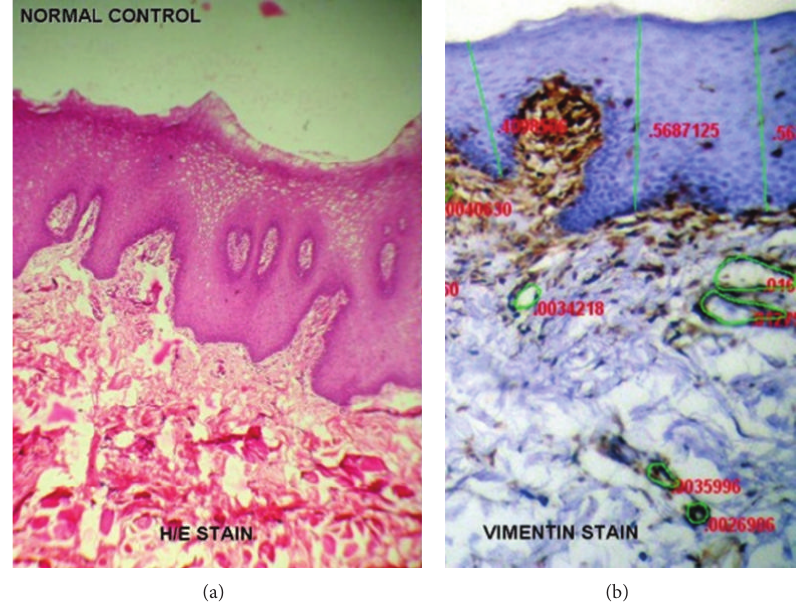
Figure 1: (a) Normal buccal mucosa under H/E staining. (b) Normal buccal mucosa under vimentin immunohistochemical staining. Vimentin is expressed in most cells of mesenchymal origin, including fibroblasts, endothelial